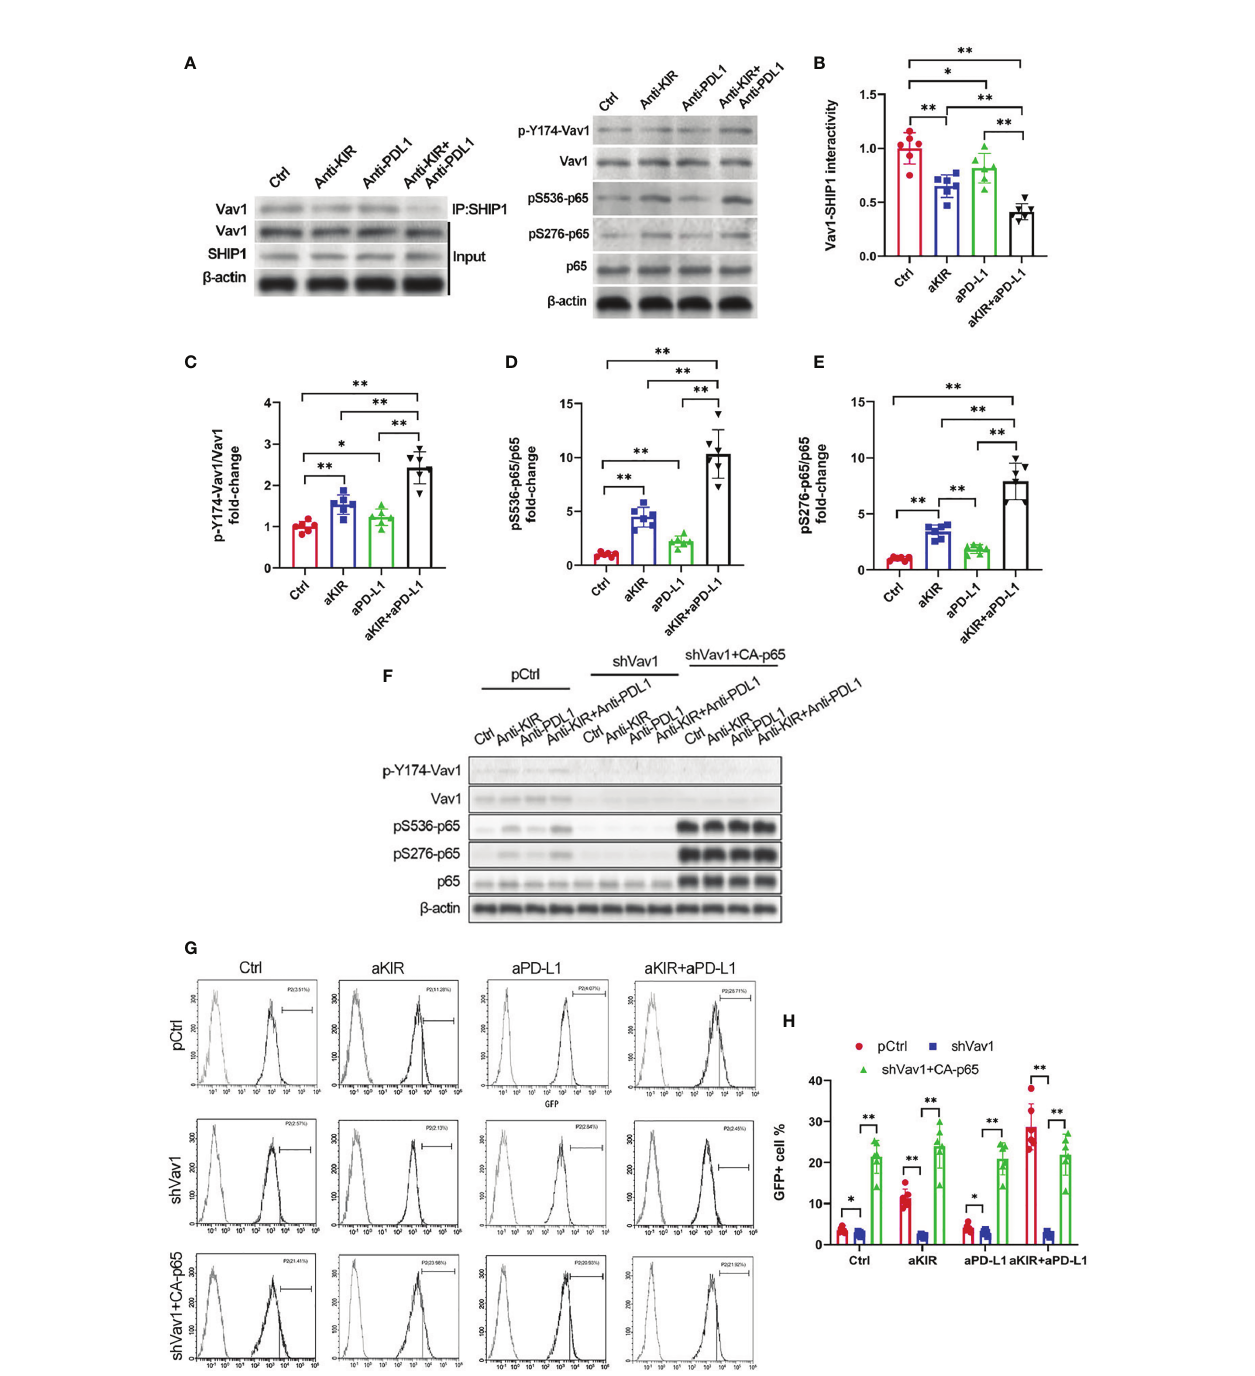
FIGURE 5 | NF- k B Disinhibition by Lirilumab and Avelumab Co-Engagement is Vav1-Dependent. (A) IL-2-primed NK cells were mixed with autologous target cells and stimulated with lirilumab (aKIR) and/or avelumab (aPD-L1) by receptor crosslinking for 4 h. Whole cell lysates underwent co-immunoprecipitation for Vav1-SHIP1 binding using an anti-SHIP1 antibody (left) or were immunoblotted for phospho-Y174 Vav1, total Vav1, phospho-S536 p65, phospho-S276 p65, total p65, and b - actin (right). (B-E) Normalized intensities of (B) Vav1-SHIP1 interactivity, (C) phospho-Y174 Vav1, (D) phospho-S536 p65, and (E) phospho-S276 p65 relative to their total counterparts are reported. (F) IL-2-primed NK cells transfected with pCtrl, shVav1, and shVav1+CA-p65 were mixed with autologous target cells and stimulated as in (A) for 4 h. Lysates from isolated NK cells were immunoblotted for phospho-Y174 Vav1, total Vav1, phospho-S536 p65, phospho-S276 p65, total p65, and b -actin. (G, H) Transfected IL-2-primed NK- k B-GFP cells were mixed with autologous target cells and stimulated with plate-immobilized aKIR and/or aPD- L1 for 6 h. GFP expression in the isolated reporter NK cells was analyzed by fl ow cytometry. * P < 0.05, ** P < 0.01 [ (B – E) one-way ANOVA or (H) two-way ANOVA (mAb factor × transfection factor)]. n= 3 biological replicates×3 technical